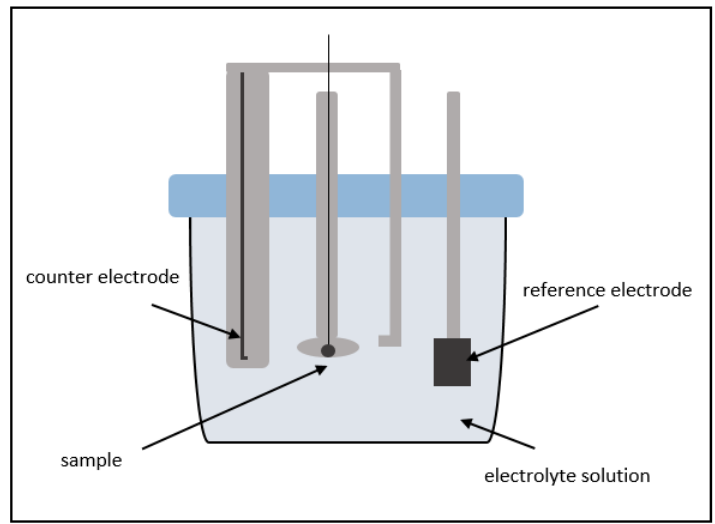
Figure 2. Schematic layout of the corrosion measuring cell. Measurements were conducted at a 0.25 m/V scan rate with ±50 mV around the rest potential. Open circuit potential (OCP) was measured for 30 min before the corrosion measurement to ensure the potential stability of the studied system. The corrosion current and the corrosion potential were defined as the intersection of two straight lines. For this purpose, Tafel fittings were applied to the linear sections of the log current-potential curve of the individual measurements in Origin Pro 2020 (OriginLab, Northampton, MA, United States) and their intersection point was determined (see Figure 3).